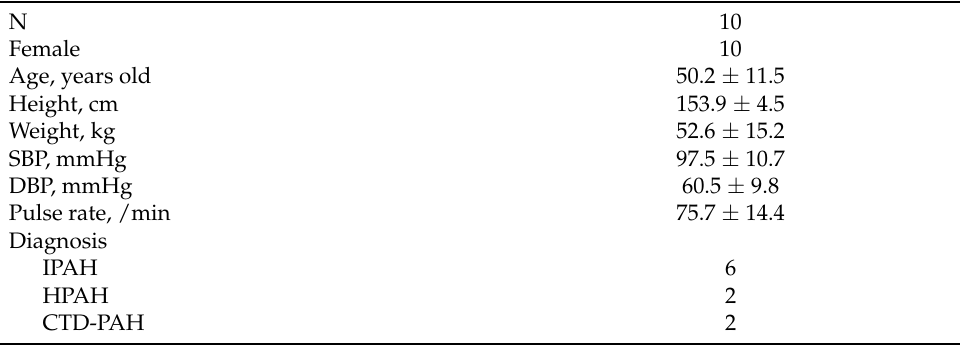
Table 1. Clinical